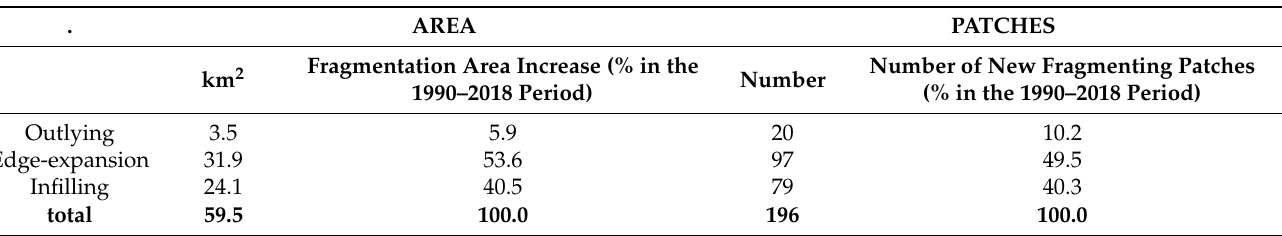
Table 1. Patterns of outlying, edge-expansion, and infilling over the 1990–2018 timeframe in Metropolitan City on Naples (MCN), Southern Italy.